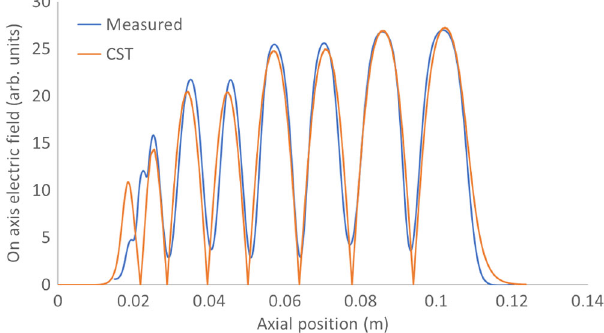
FIG. 15. Magnitude of S 11 for the X -band cavity. The S 11 measurement performed by the manufacturer is shown in blue and the S 11 measurement performed on receipt of the cavity is shown in orange.